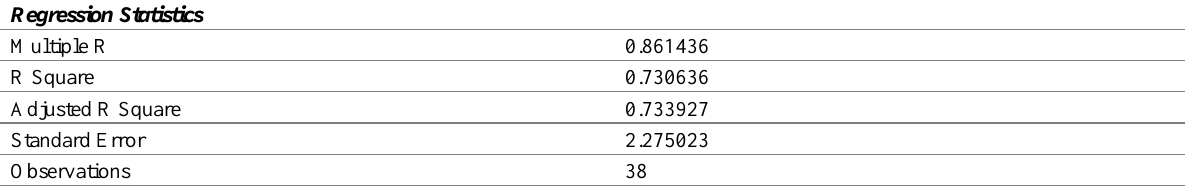
Table 1: Regression Model